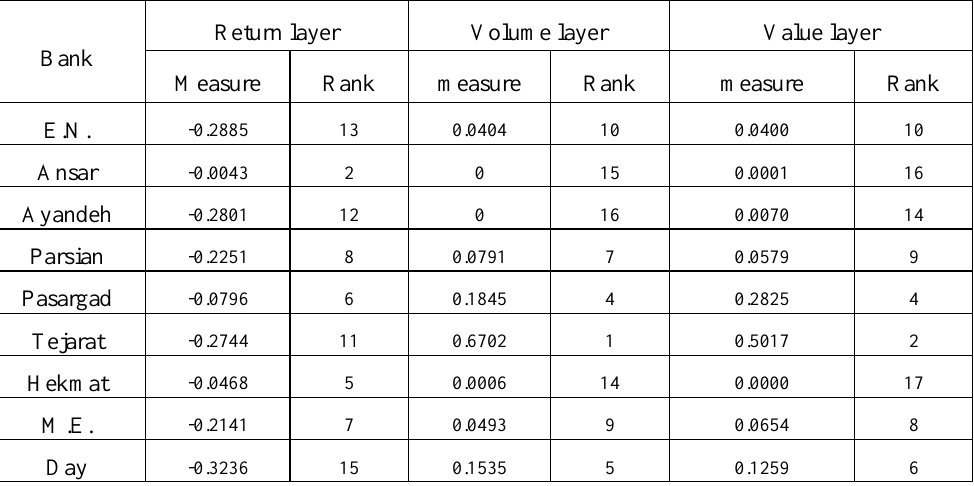
Table 5. Eigen vector centrality in each